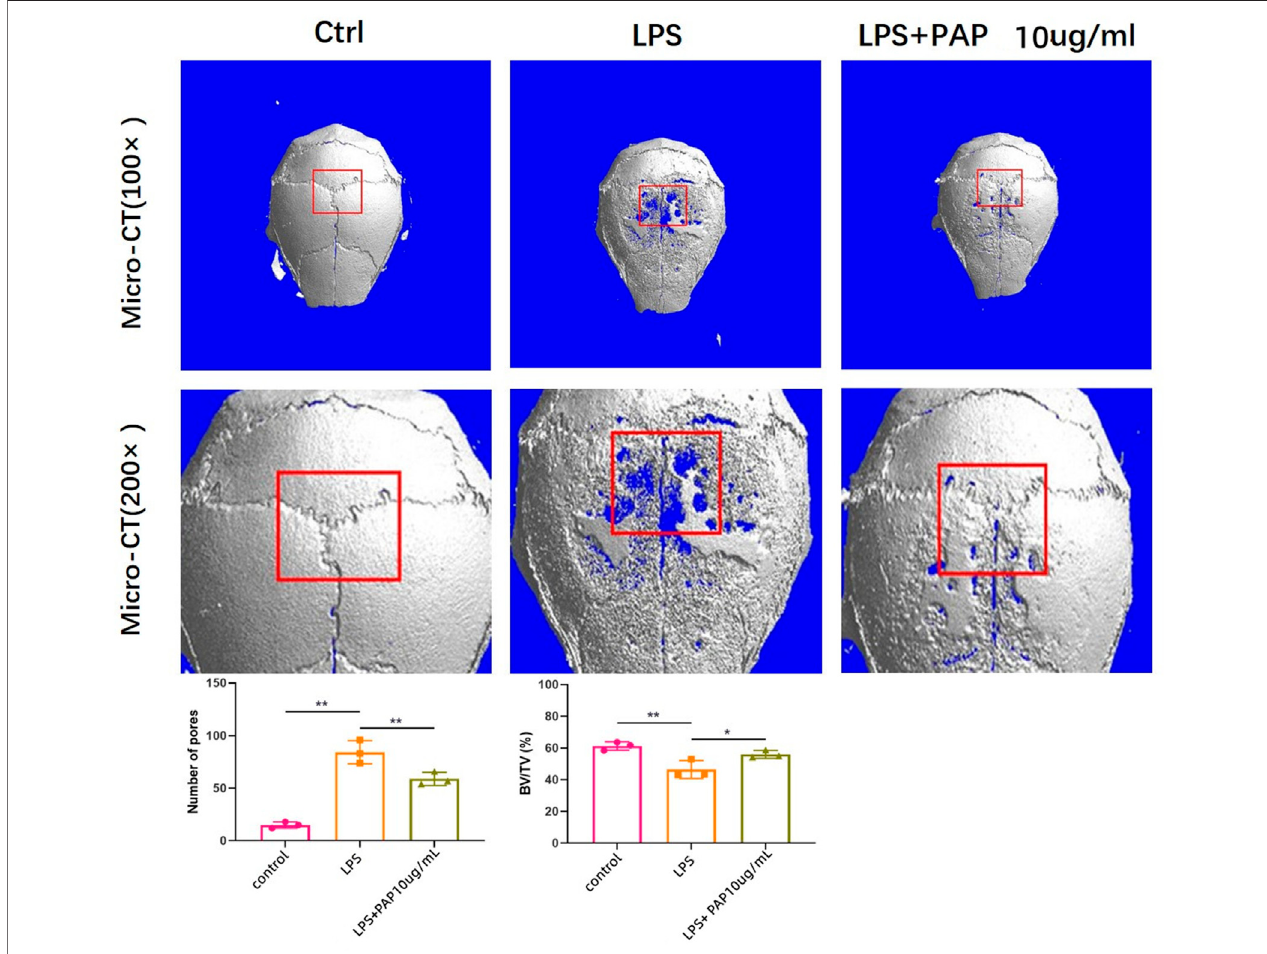
FIGURE4| Microcomputedtomography ofmouse cranialboneresorption.Redbox arearepresentsboneresorptionlacunae,quantitativelyanalyzed tomeasure new bone volume percentage. **p < 0.01, *p < 0.05.